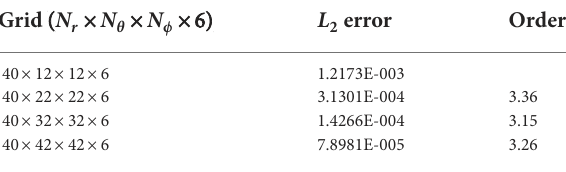
TABLE 1 L 2 error and the order of accuracy for Φ